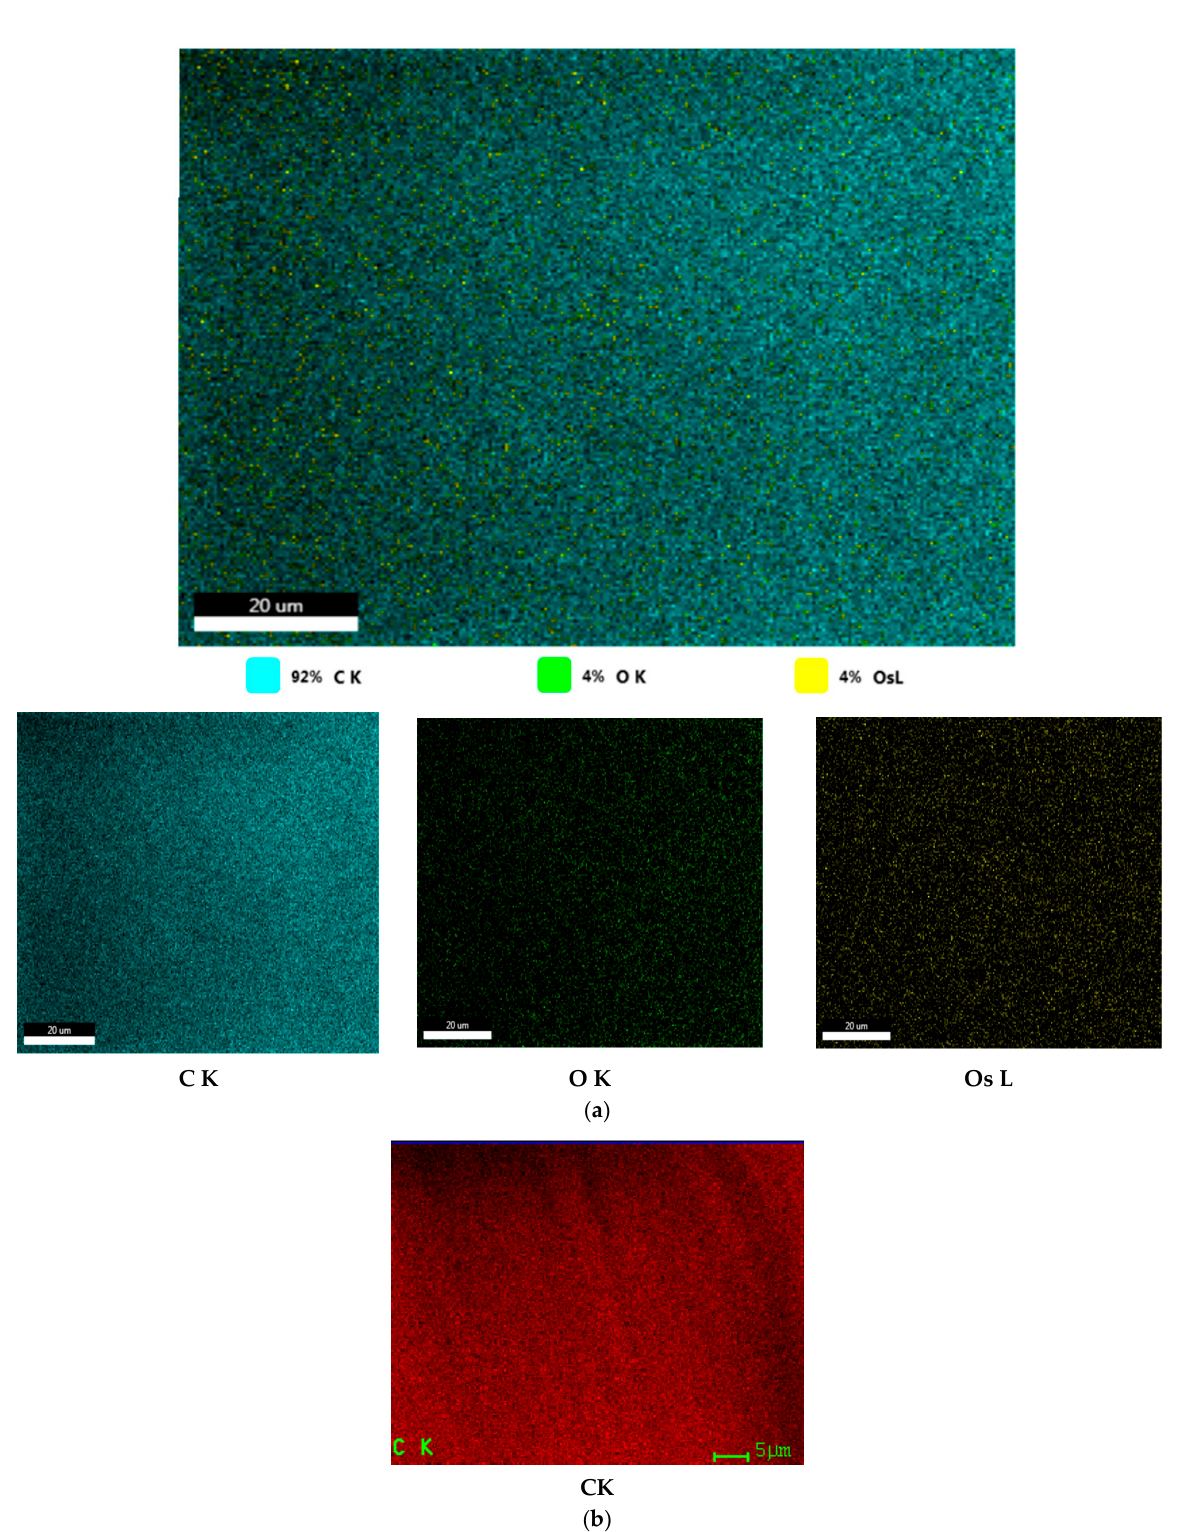
Figure 6. Elements distribution map obtained by energy-dispersive spectroscopy analysis (EDAX) on: ( a ) osmium nanoparticle–polymer composite membranes, obtained in n -decanol (Os–PPM n ); ( b ) polypropylene polymer support.